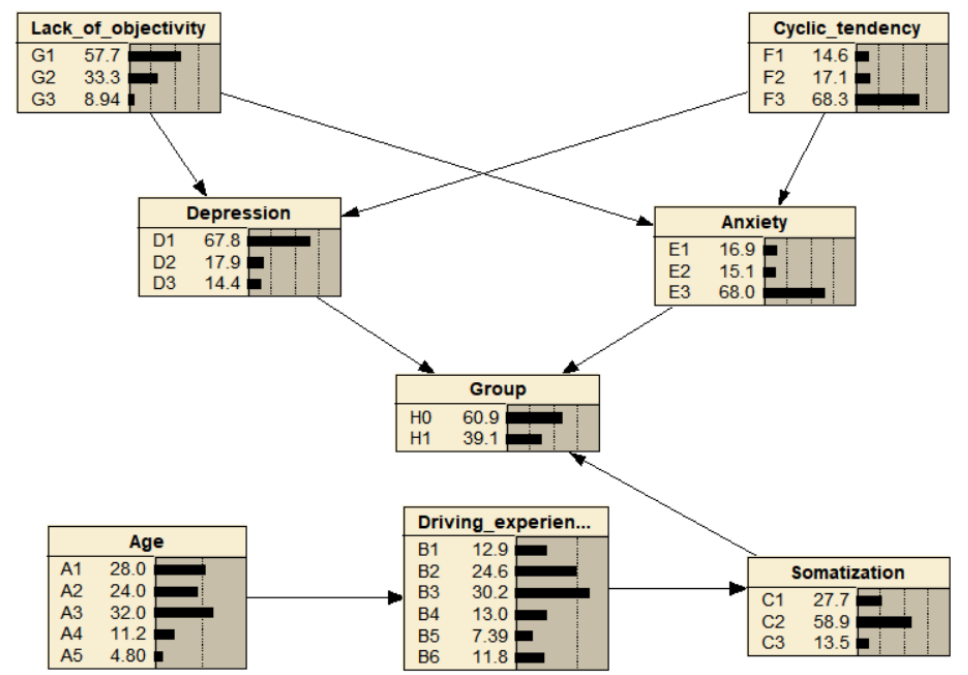
Figure 5. Bayesian network model of bus drivers’ mental health and traffic safety assessment after Netica parameter learning.